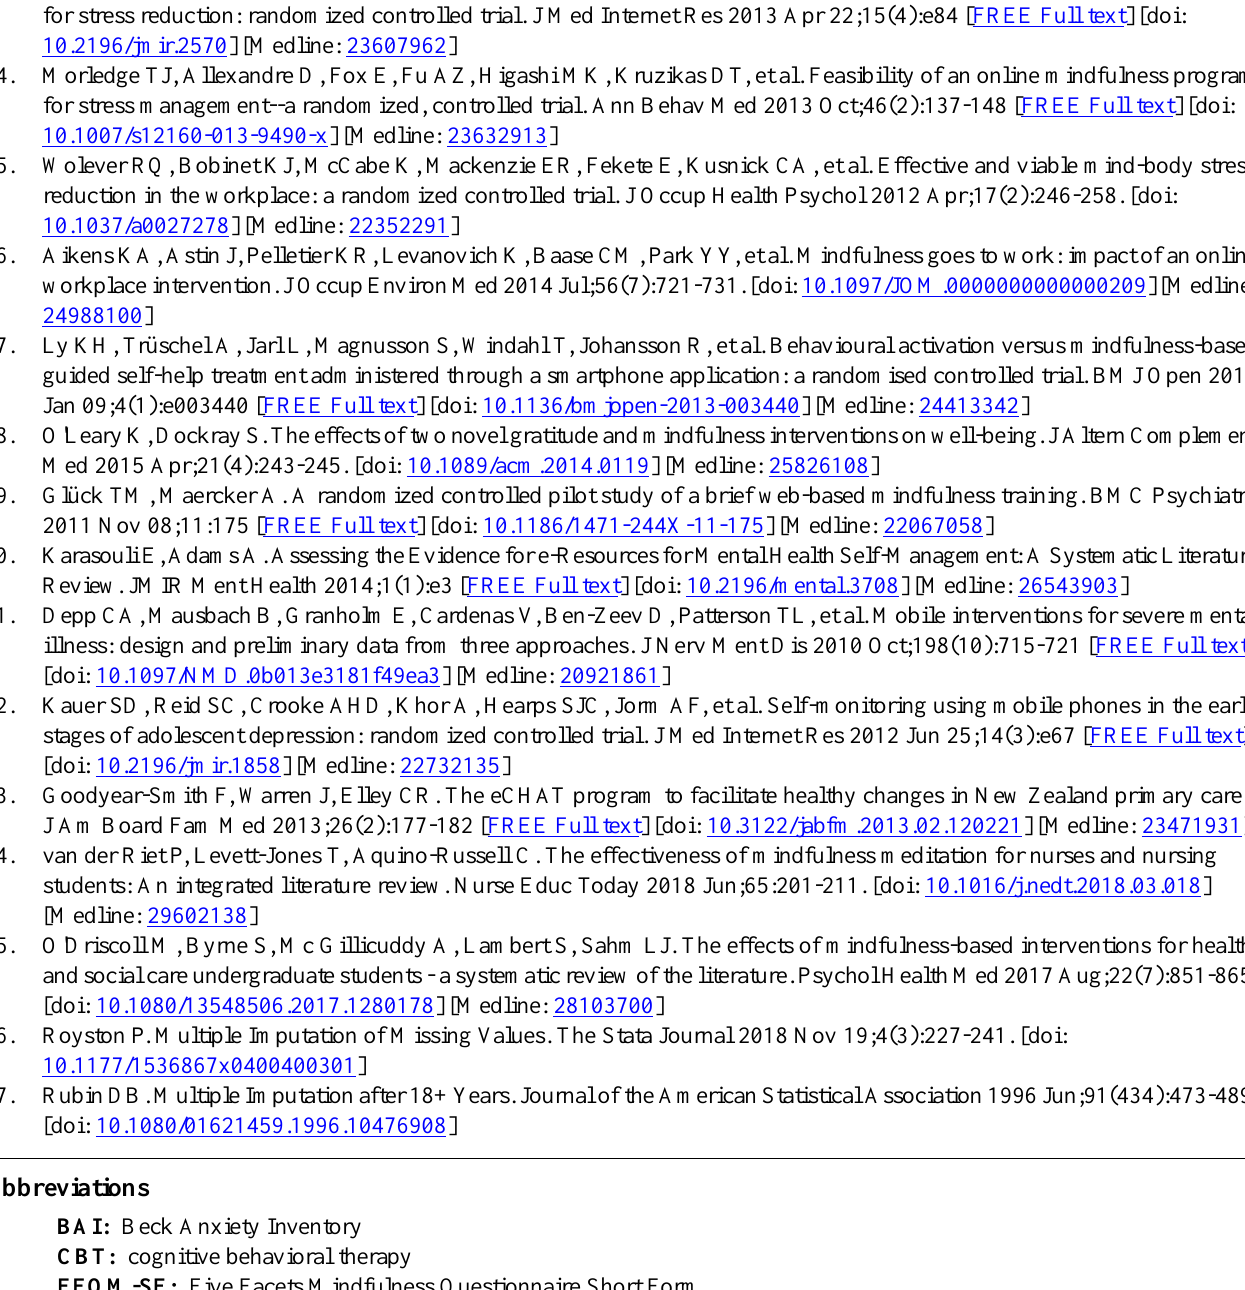
Abbreviations BAI: Beck Anxiety Inventory CBT: cognitive behavioral therapy FFQM-SF: Five Facets Mindfulness Questionnaire Short Form MVC: Mindfulness Virtual Community PHQ-9: Patient Health Questionnaire-9 PSS: Perceived Stress Scale RCT: randomized controlled trial WLC: waitlist